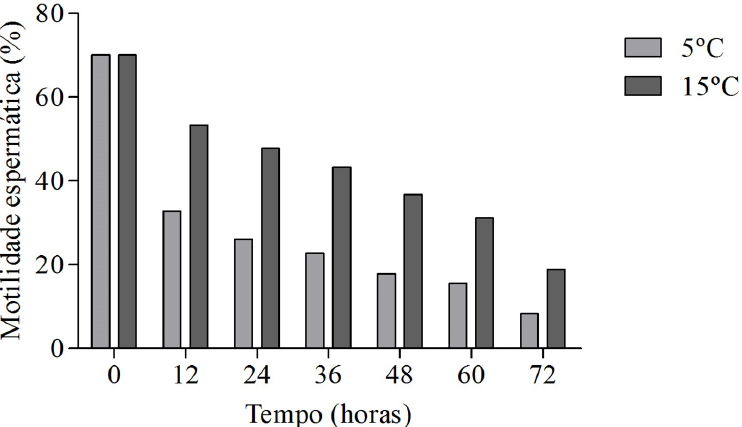
Figura 2. Médias de motilidade (%) das amostras de sêmen submetido à refrigeração nas temperaturas 5 ou 15 °C,